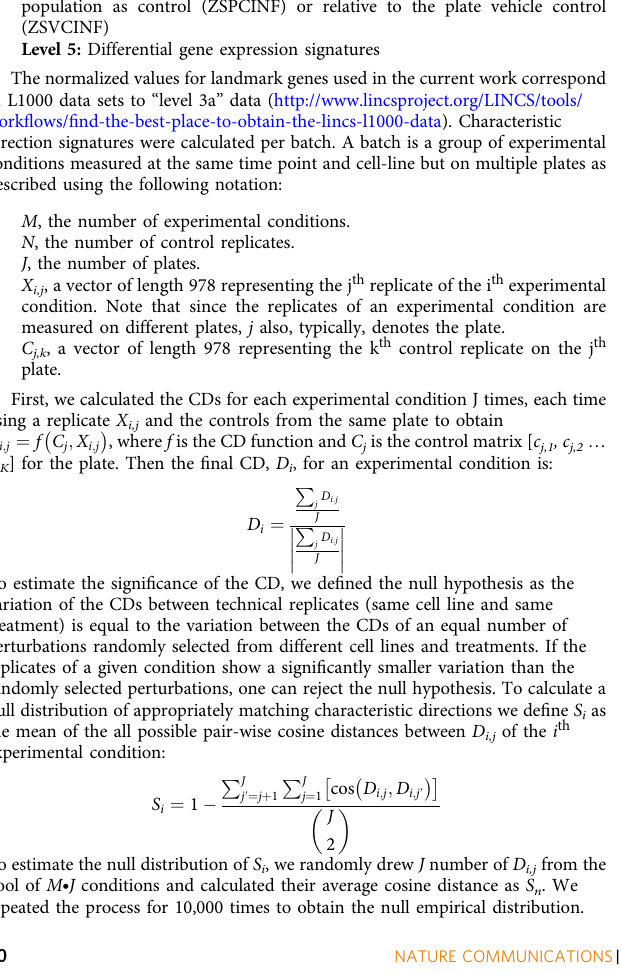
● Level 3: Quantile-normalized gene expression pro fi les of landmark genes and imputed transcripts (QNORM or INF) ● Level 4: Gene signatures computed using z-scores relative to the plate population as control (ZSPCINF) or relative to the plate vehicle control (ZSVCINF) ● Level 5: Differential gene expression